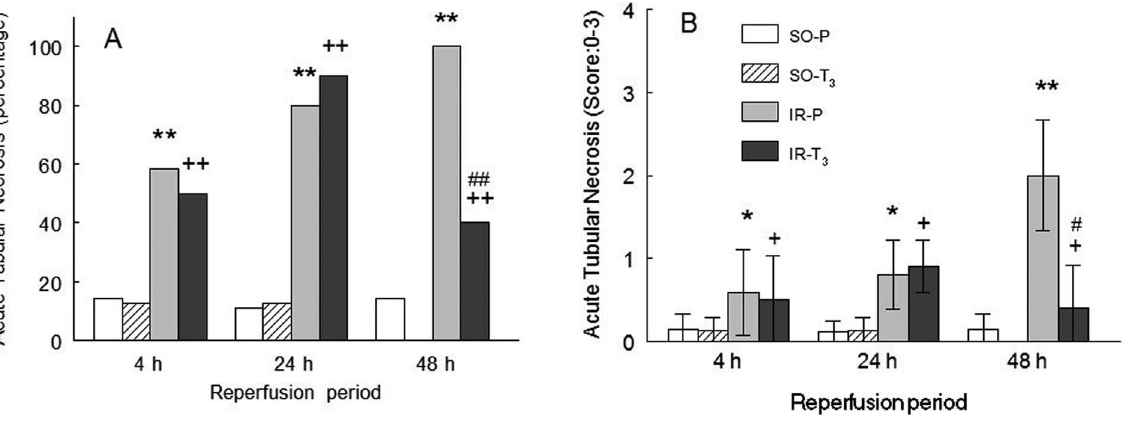
Figure 6. Percentage (A) and score (B) of acute tubular necrosis in the experimental groups. (n=10 each group): SO-P= sham-operated- placebo; SO-T